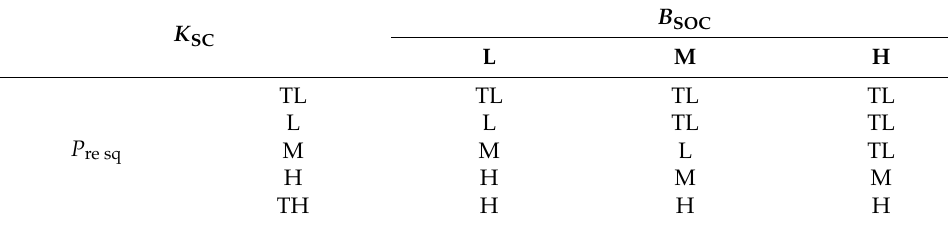
Table 4. Fuzzy control rules ( S SOC =